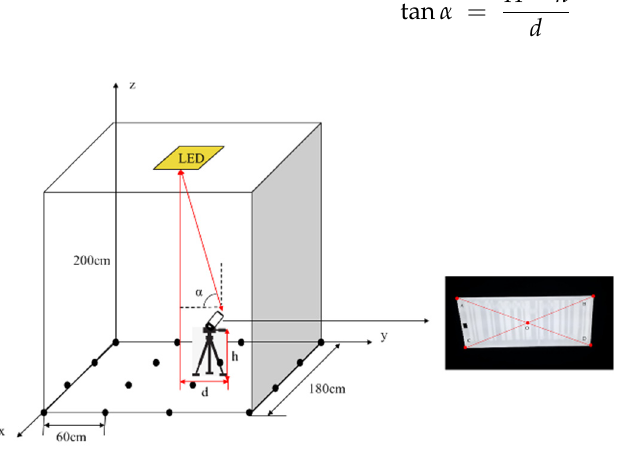
Figure 9. Experimental schematic of precise positioning.